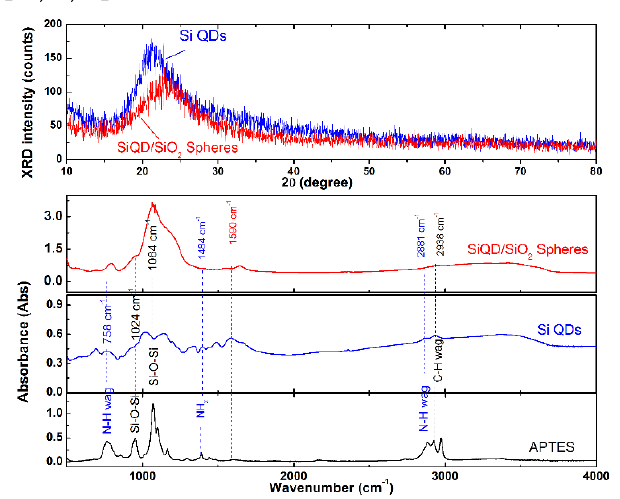
Fig. 1. XRD patterns (upper panel) and FTIR spectra (lower panel) of Si QDs and Si/SiO 2 Spheres containing samples